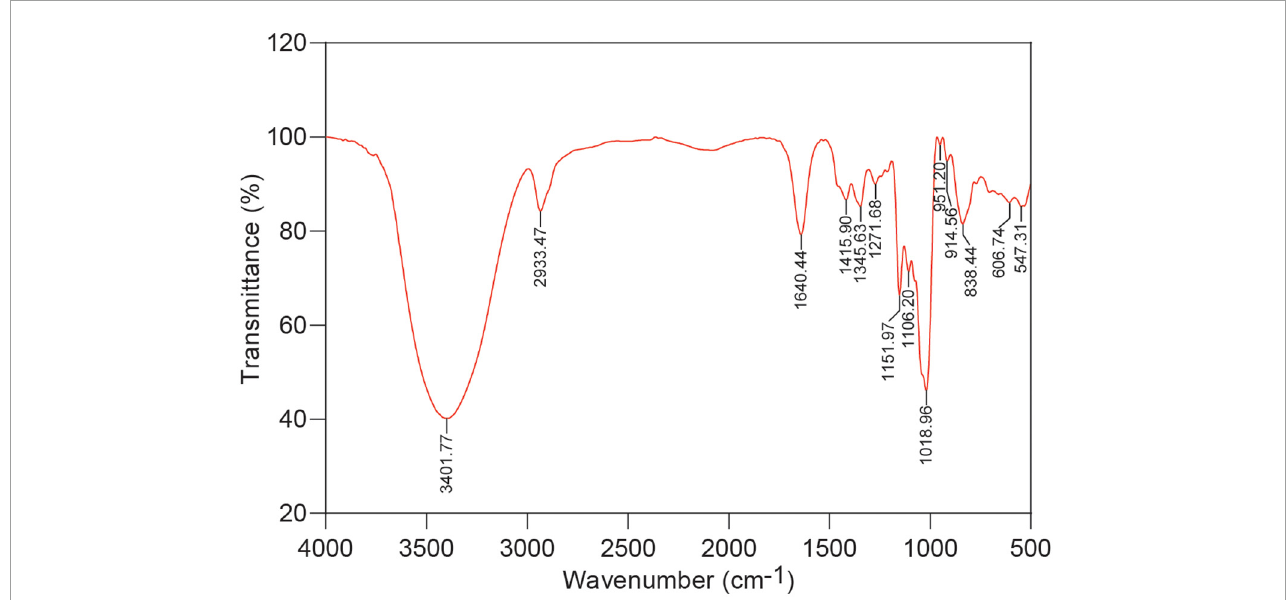
FIGURE2 Fourier transform infrared (FT-IR) spectra of exopolysaccharide (EPS) obtained from Leu. mesenteroides